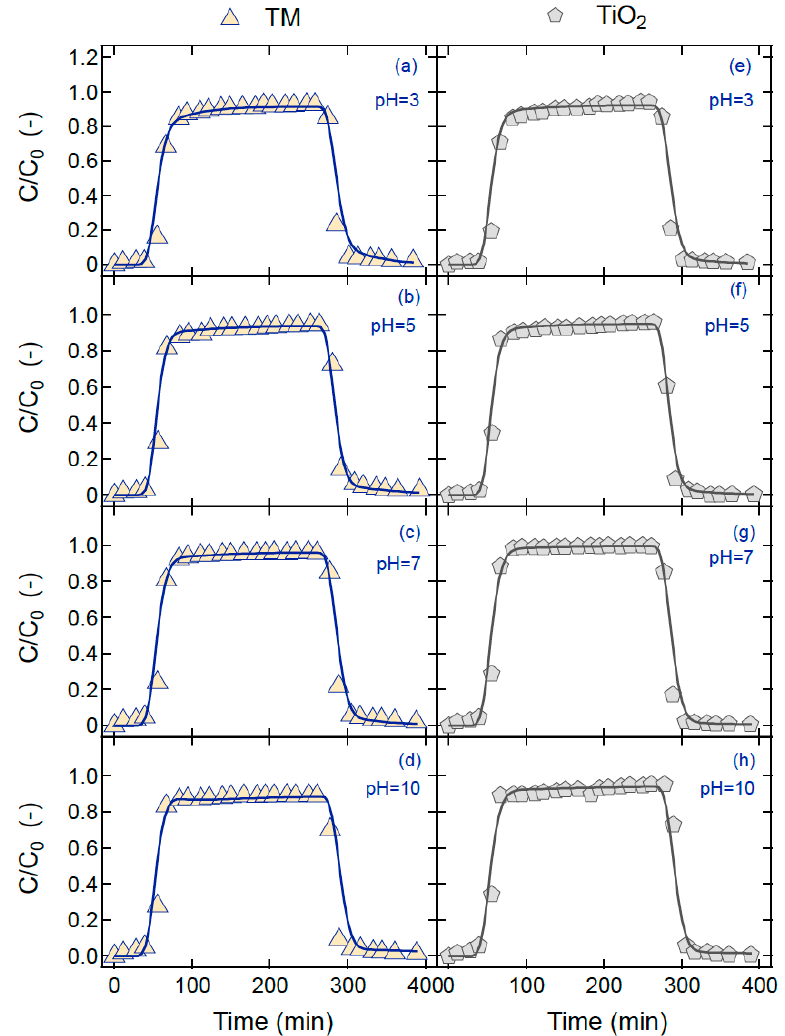
Figure 5. Breakthrough data (symbols) for the cotransport of TM (triangles) ( a – d ) and TiO 2 (pen- tagons) ( e – h ), together with the corresponding fitted curves (solid curves), in a column packed with quartz sand, at 4 different pH values (pH = 3, 5, 7, and 10) as a function of time.